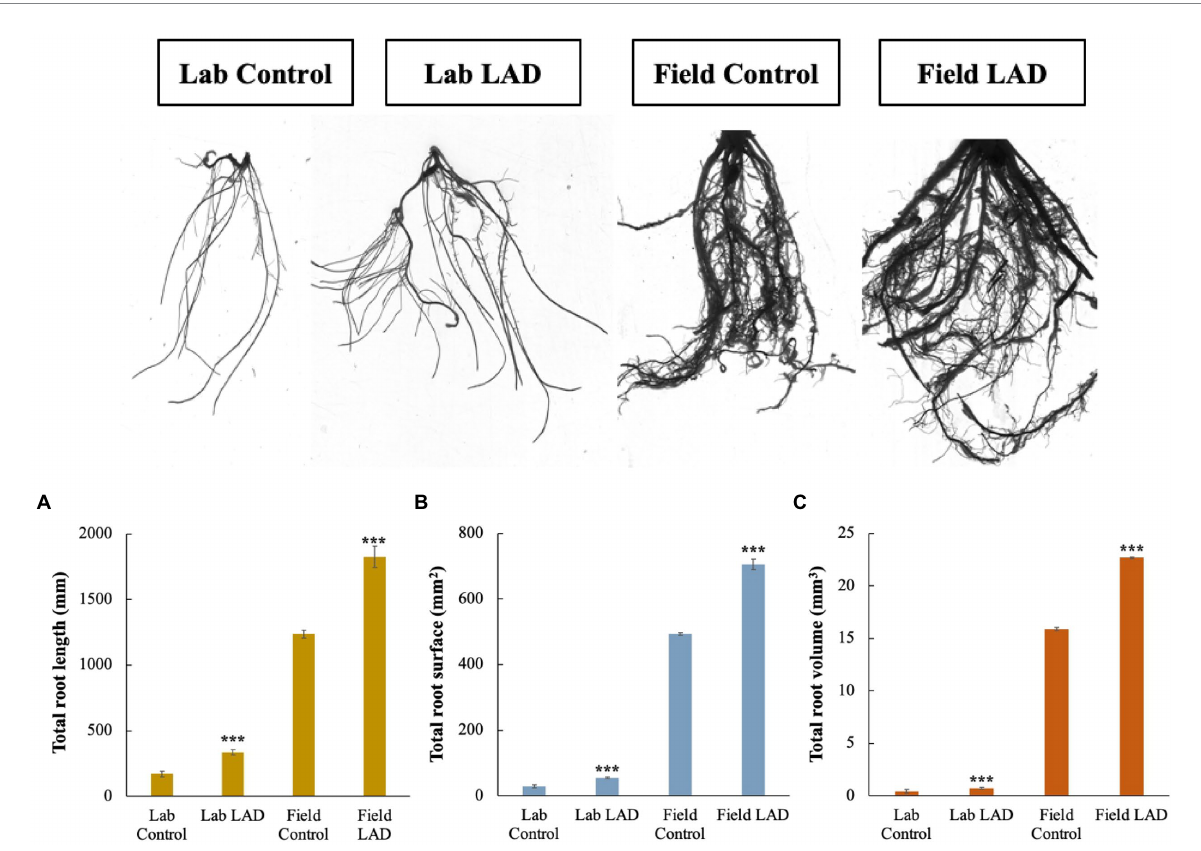
FIGURE 7 Maize root development in laboratory and field soils impacted by B. aryabhattai LAD. (A) The impacts of LAD on the maize root length. (B) The impacts of LAD on the maize root surface area. (C) The impacts of LAD on the maize root volume. Lab control: the root of the maize seedlings treated with water and cultivated in laboratory soil for 14 d; Lab LAD: the root of the maize seedlings treated with LAD and cultivated in laboratory soil for 14 d; Field control: the root of the maize seedlings treated with water and cultivated in laboratory soil for 60 d; Field LAD: the root of the maize seedlings treated with LAD and cultivated in laboratory soil for 60 d. Each treatment had 10 maize plants and was repeated three times. Student’s t -test was used to compare the root development under LAD treatment with that of the control. Statistical differences were shown with asterisks (i.e., *** representing p <